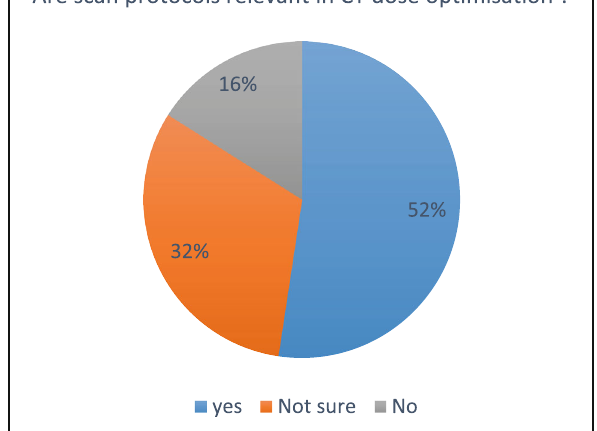
Fig. 3 Participants ’ knowledge of scan protocols